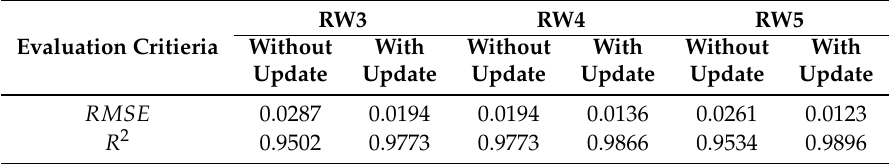
Table 6. SOH estimation